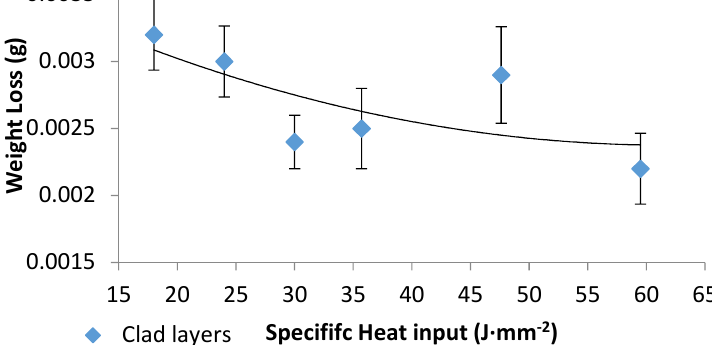
Figure 17. Clad layer weight loss versus the specific heat input.